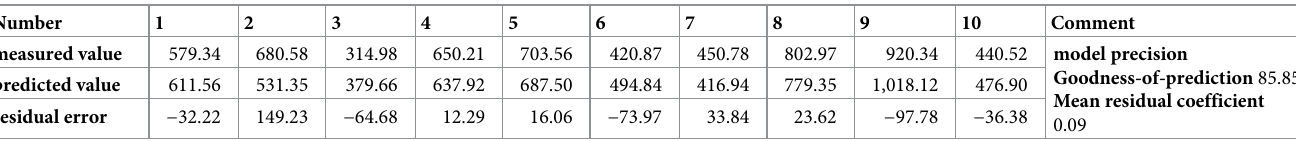
Table 1. Tests for accuracy of the biomass multivariable linear regression models.